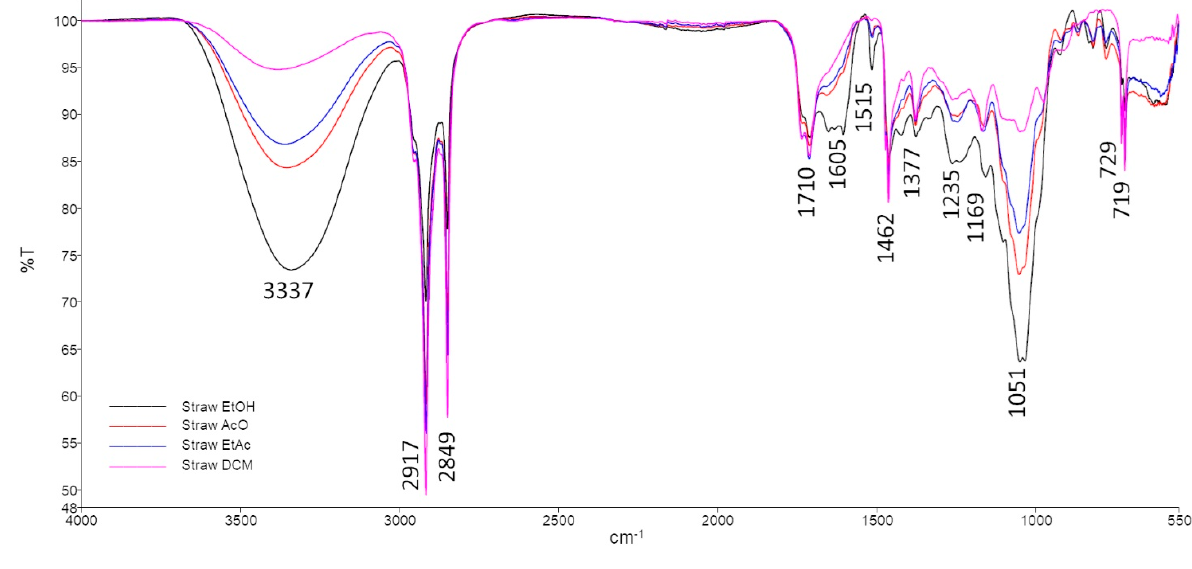
Figure 3 . FTIR spectra of straw extracts.